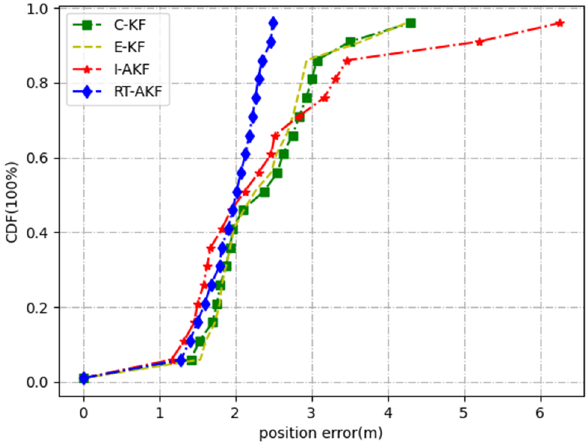
Figure 19. Accuracy comparison by different methods in segment #7.